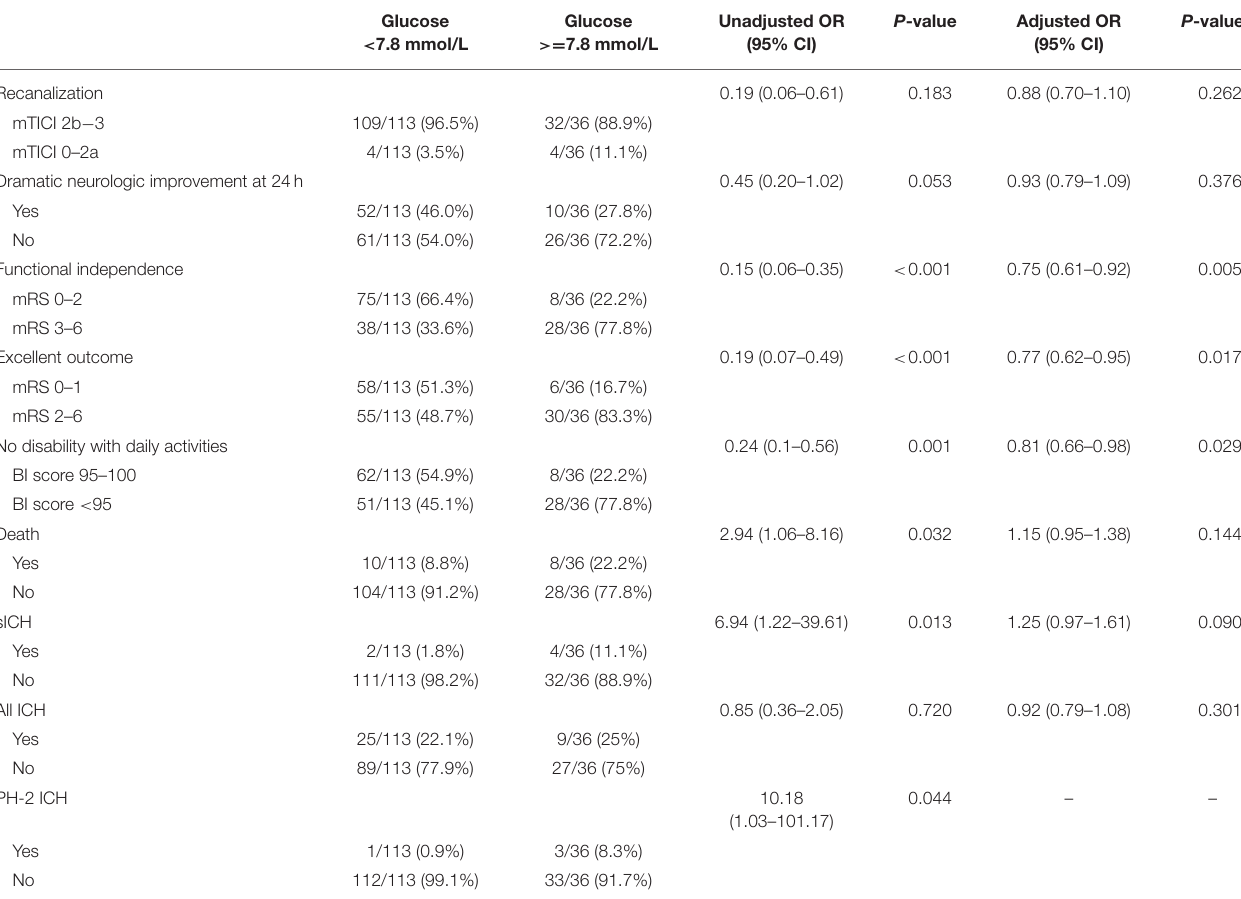
TABLE 4 | Association of Hyperglycemia at presentation with clinical outcomes by univariable and multivariable logistic